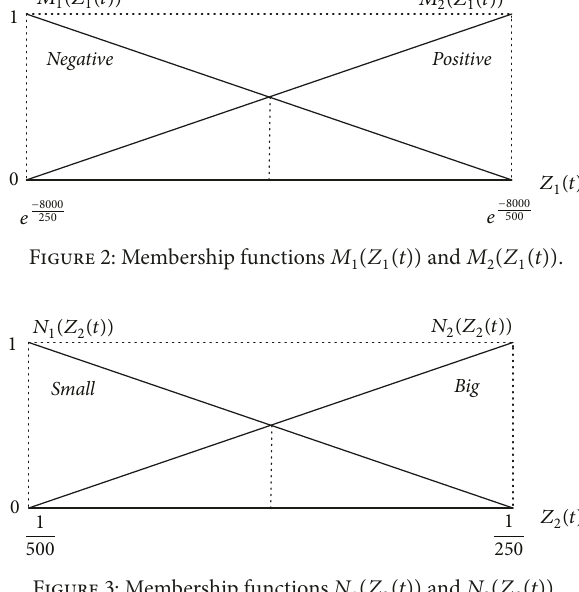
Figure 3: Membership functions 𝑁 1 (𝑍 2 (𝑡)) and 𝑁 2 (𝑍 2 (𝑡)) .